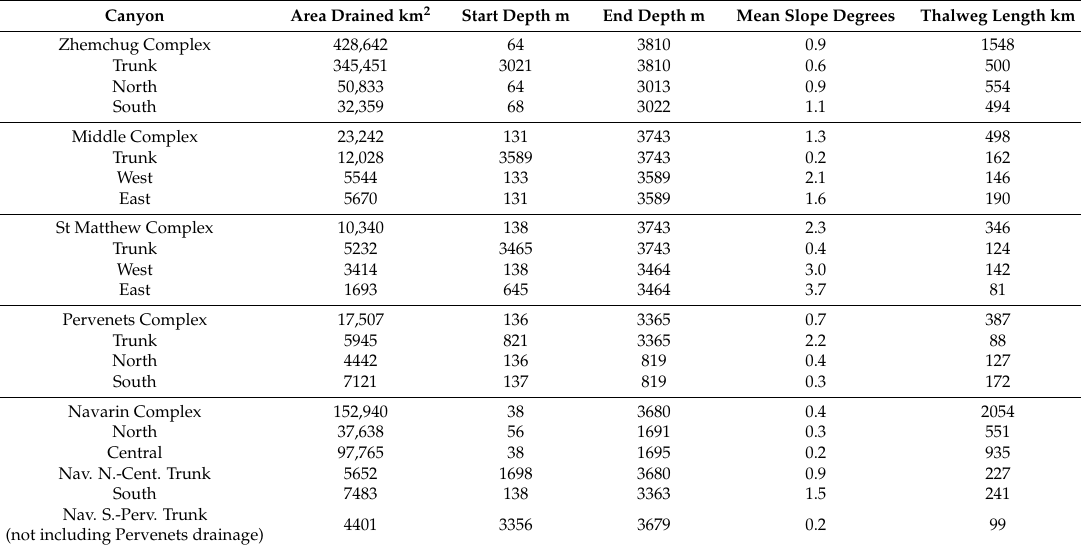
Table 3. Navarin Canyon names and metrics described from south to north.